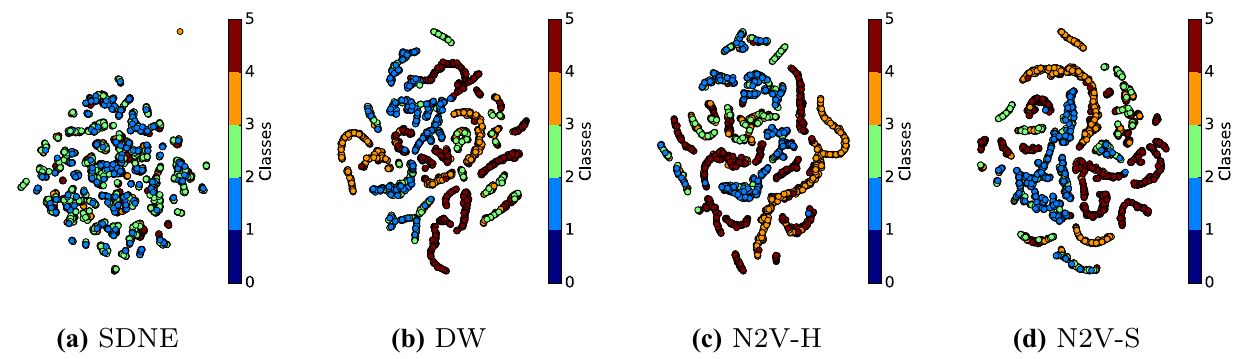
Fig. 10 t-SNE plots of the embeddings taken from the ego-Facebook dataset, where the points are coloured according to their eigenvector cen- trality (EC)